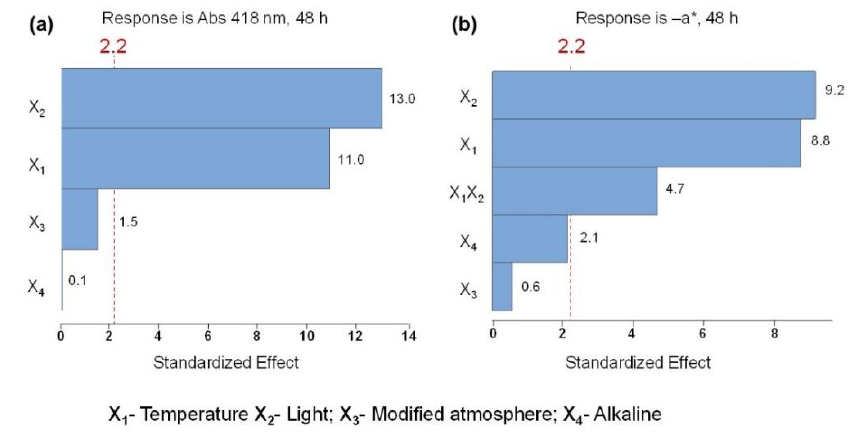
Figure 5. Pareto charts of the standardized effects: ( a ) response is Abs (418 nm), 48 h ( p < 0.05); ( b ) response is the value of greenness ( − a*), 48 h ( p < 0.05).